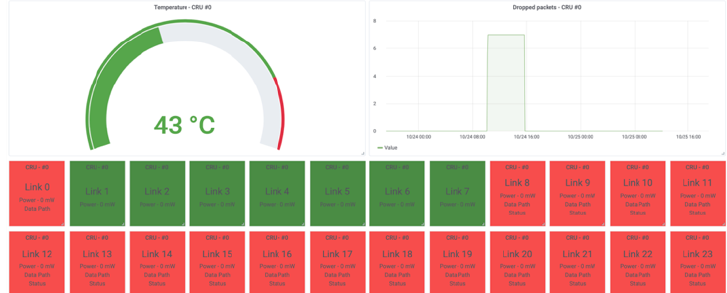
Fig. 4. Status of single CRU readout card: temperature, dropped packets and status of its 24